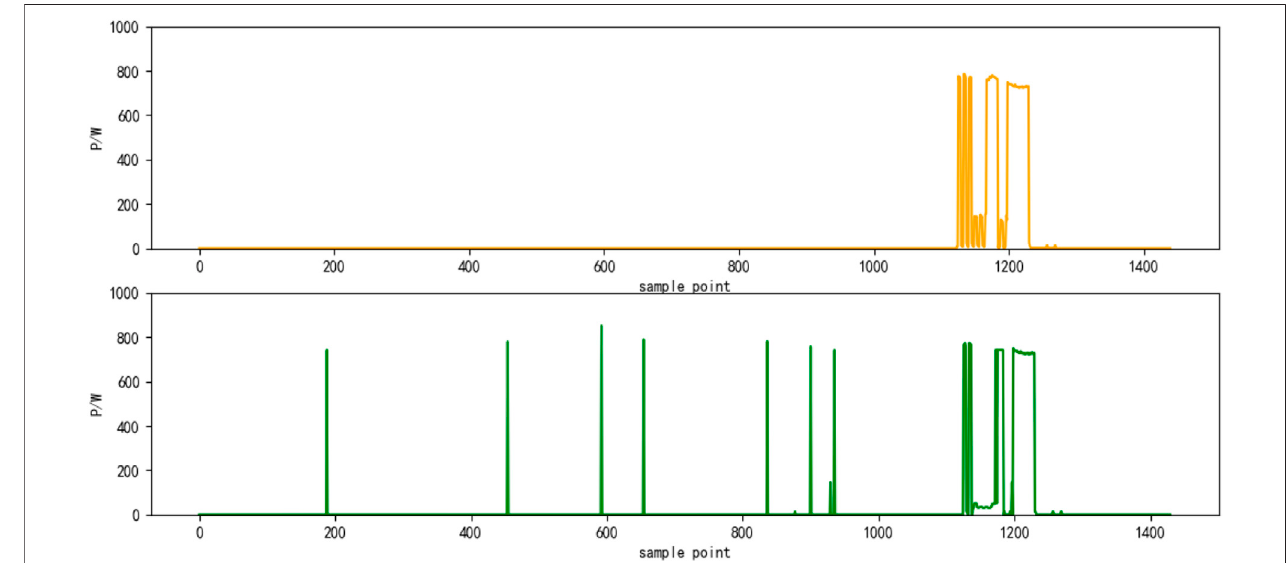
FIGURE 6 | Results of power decomposition (CDE).